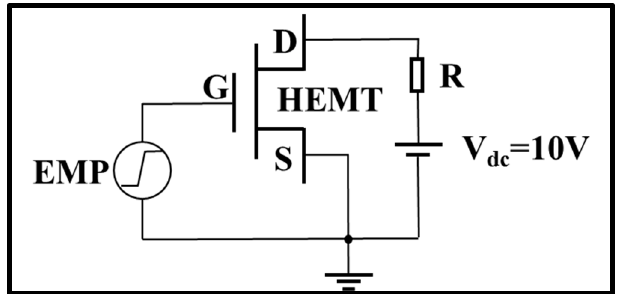
Figure 2. Schematic diagram of the circuit with the input injection.